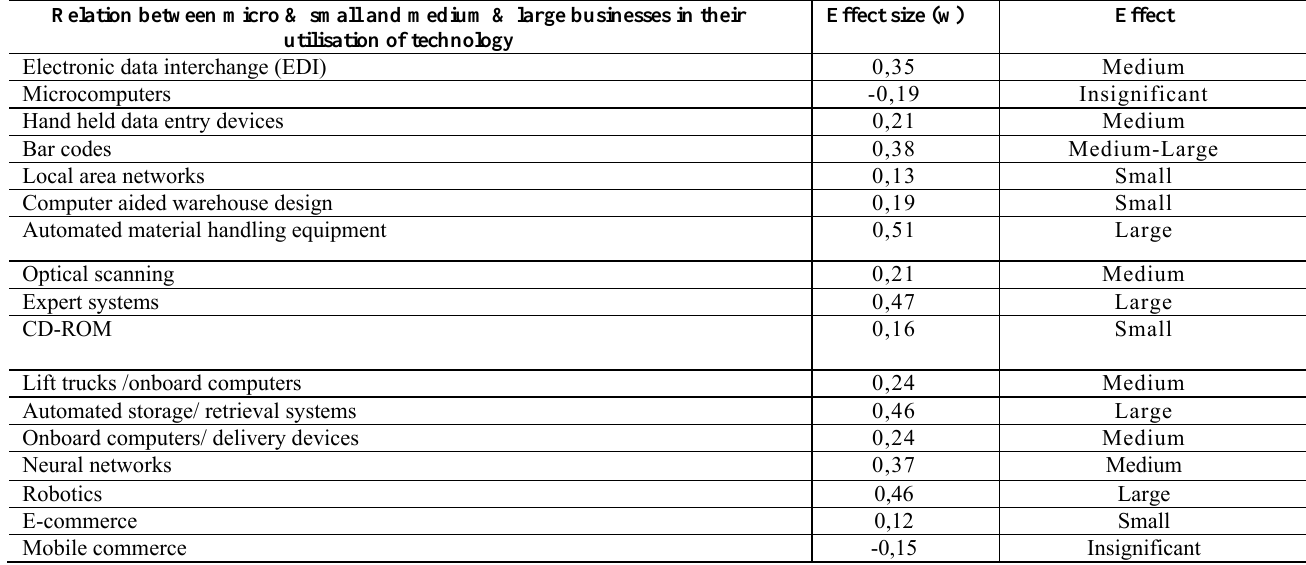
Table 7: Different business sectors and technology utilisation Relation between micro & small and medium & large businesses in their